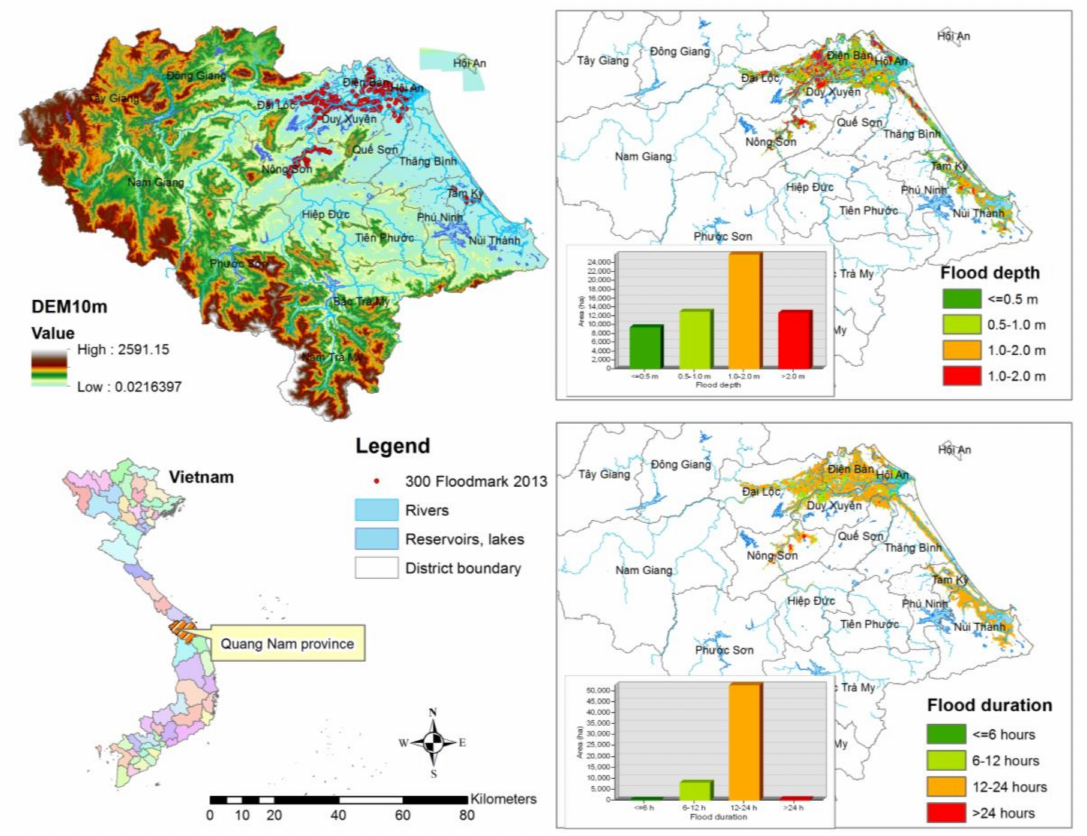
Figure 1. The location of study area, Quang Nam province and flood hazard mapping created by Luu et al.